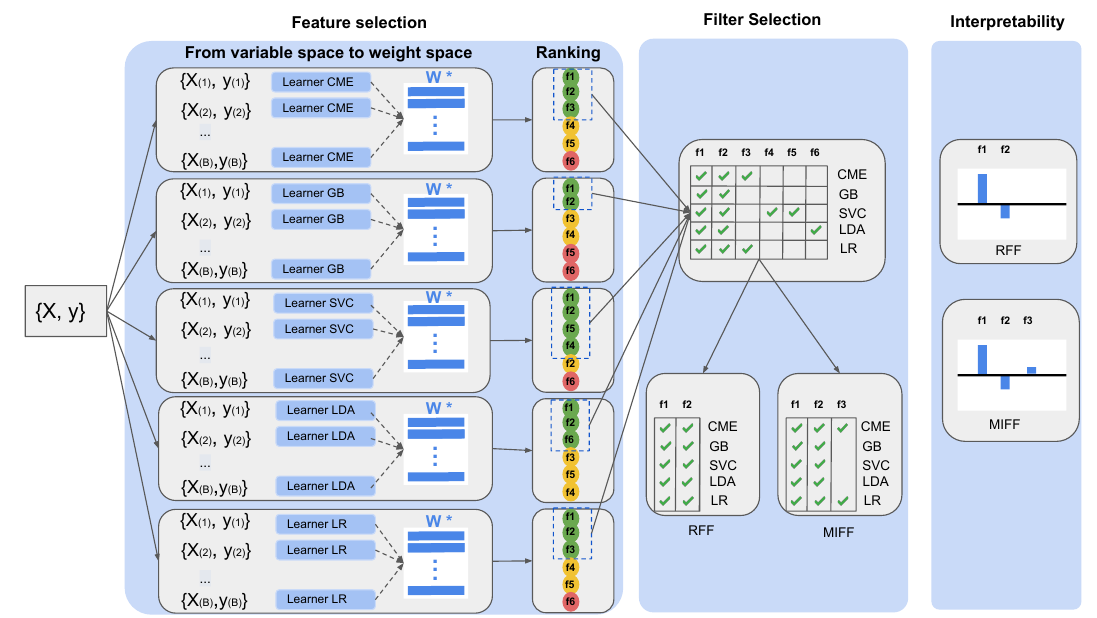
Figure 1. Methodology. In the FS, the features are transformed into a coefficient space using IVI with different ML algorithms (CME, GB, SVC, LDA, and LR). Through the use of confidence intervals and relations between feature, we compose the rankings of informative features. In the filter step, we apply the filters to detect recurrent features and maximally-informative features. Finally, in the last step, using the features provided by the filter we trained, with linear models, we get the weights assigned to each of these features. Those weights reflect the importance of features in the decision